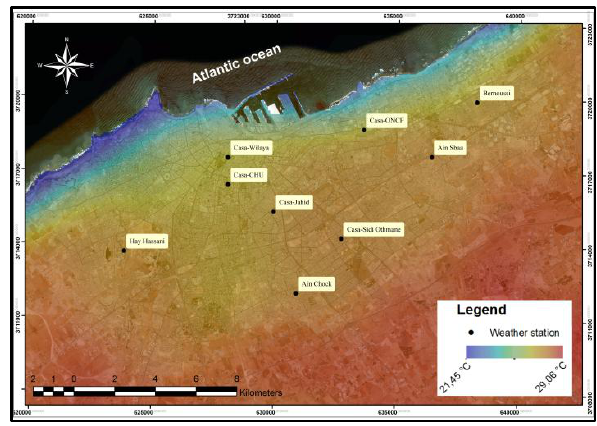
Figure 13. Spatial distribution of maximum air temperature estimated from daytime MODIS observation during the 7th of August